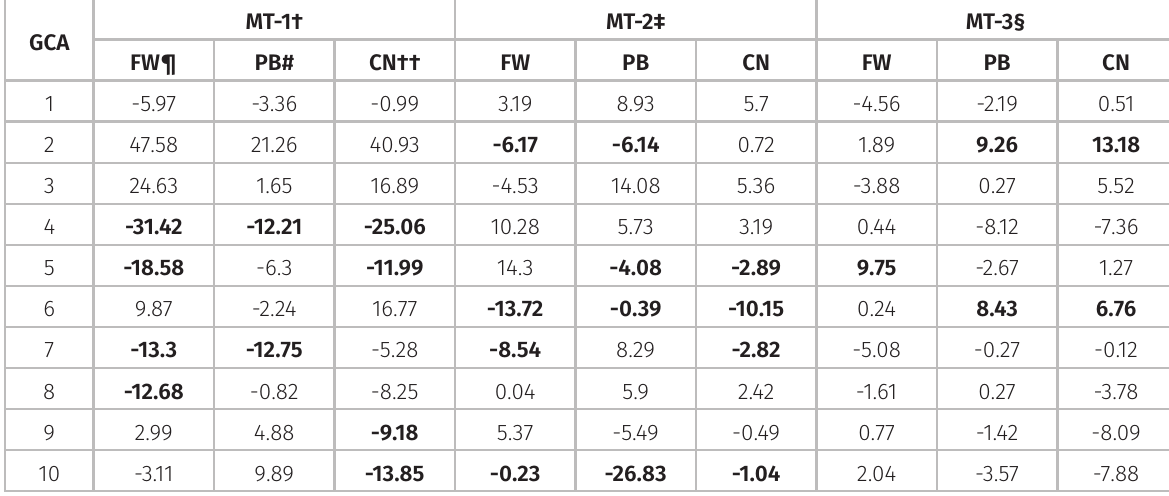
Table III. Estimates of general combining ability (GCA) for three mega-traits in a joint diallel analysis with F reciprocal grown in three sites. Bold-highlighted values are the favorable combining for each